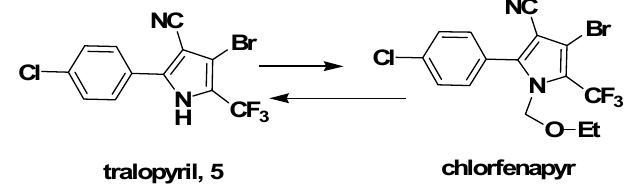
Figure 1. Chemical structure of tralopyril and chlorfenapyr.